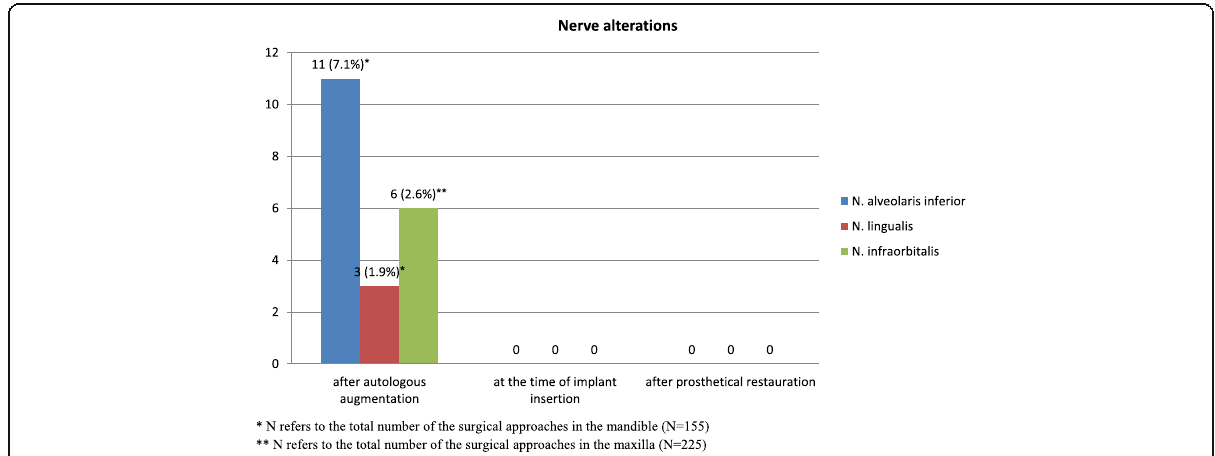
Fig. 4 Postoperative nerve alterations. Single asterisk , N refers to the total number of the surgical approaches in the mandible ( N = 155). Double asterisk , N refers to the total number of the surgical approaches in the maxilla ( N =